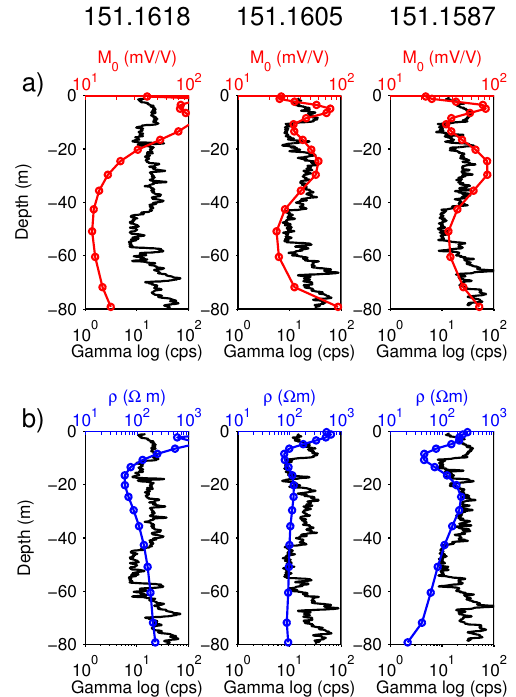
Fig. 10. Gamma logs (black) in comparison with 1-D inver- sion models derived from surface measurements for Profile 4. (a) Chargeability M0. (b) Resistivity. The names of boreholes are specified on the map Figure